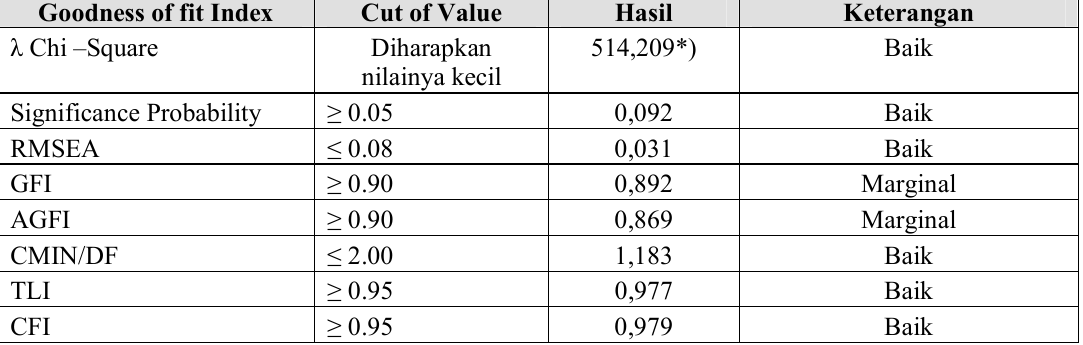
TABEL 3. I(cid:9)DEKS PE(cid:9)GUJIA(cid:9) KELAYAKA(cid:9) STRUCTURAL EQUATIO(cid:9) MODEL _ MODEL EMPIRIK